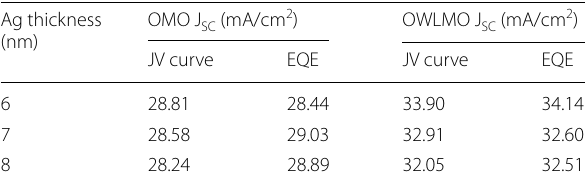
Table 1 Short‑circuit densities as calculated from EQE and JV measurements are in good agreement